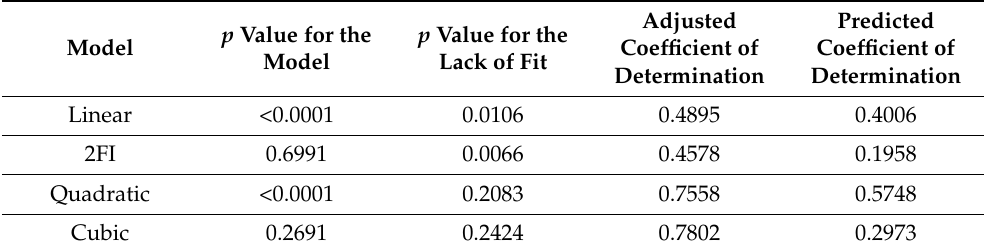
Table 4. Simulation of four models in Design Expert for notch corrosion after 120 h in the salt-spray test chamber.